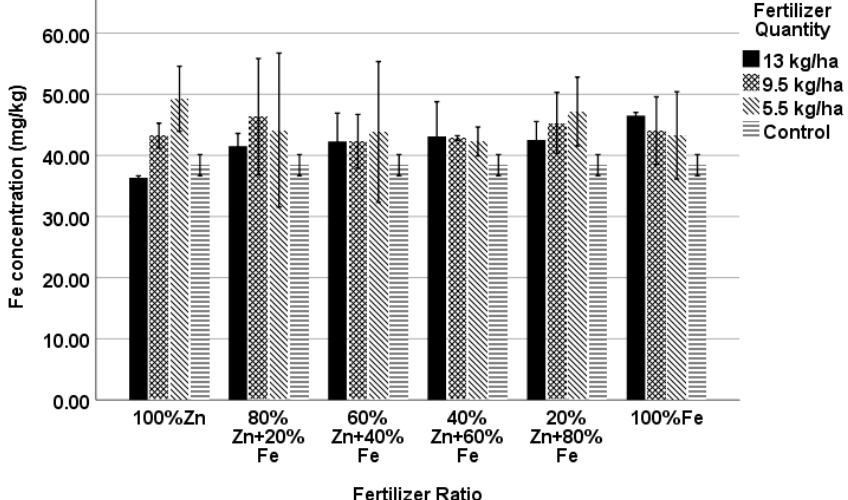
Figure 5. Concerning the foliar application of combined Zn and Fe fertilizers on wheat grain Fe concentration. Values plotted are the means of both copping seasons. Vertical bars represent the 95% confidence interval.